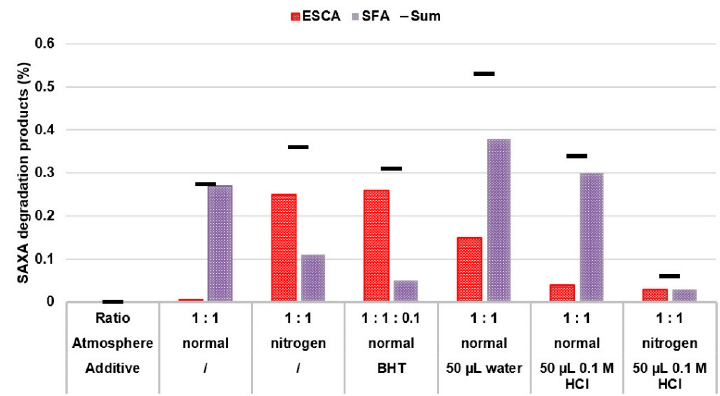
Figure 10. Binary mixtures study. Changes in atmospheric gas composition and additives are graphed. Individual saxagliptin (SAXA) degradation products and their sum are plotted on the y-axis (in % of SAXA). Drug substance to excipient weight ratio for each sample is given. When binary mixture of SAXA and PEG is flushed with nitrogen, ESCA forms predominantly; conversely, in the sample without nitrogen flushing, intra-molecular cyclization is completely inhibited and only SFA forms. As in film-coated tablets, sum of impurities is comparable in both samples, only slightly lower when at normal atmospheric conditions. Butylhydroxytoluene (BHT)